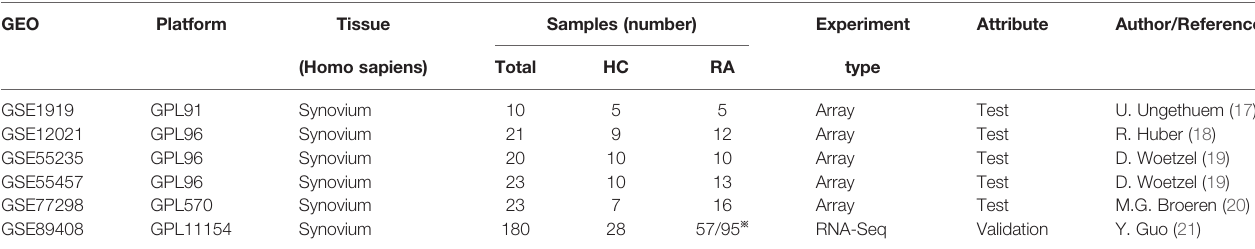
TABLE 1 | Basic information of selected datasets.